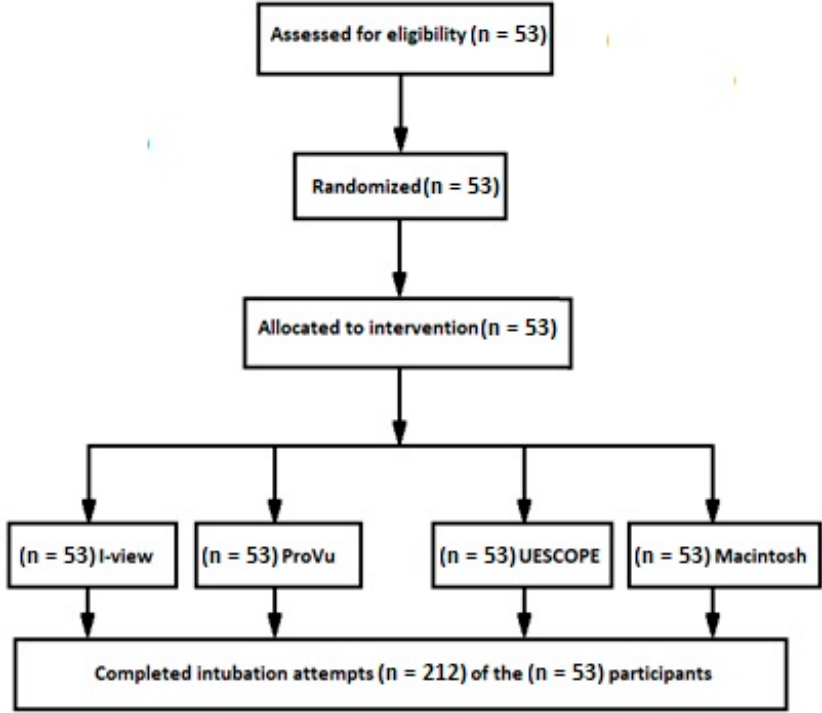
Figure 3. Randomization flow chart.